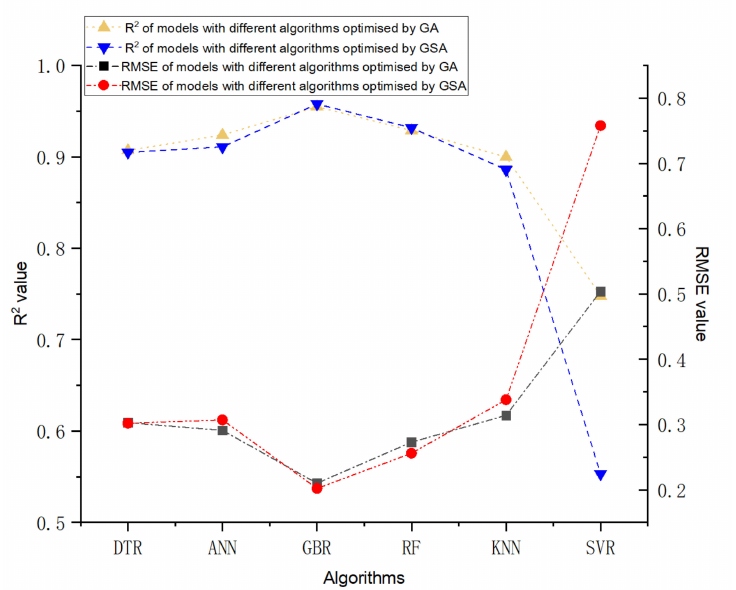
Figure 4. The differences of R 2 and RMSE value of six types of ML models tuned by GSA and GA.